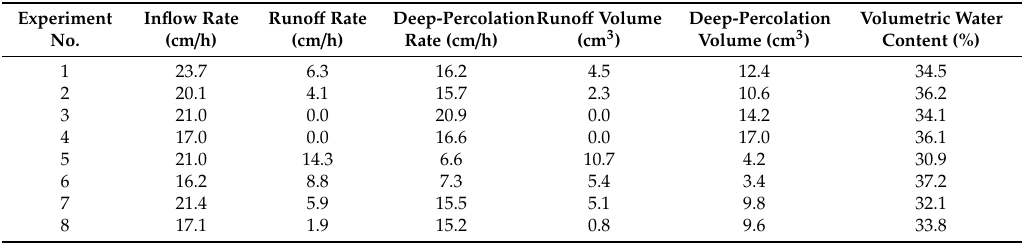
Table 3. Summary of steady state runo ff measured at the outlet and deep-percolation rates and volume measured at the drainage face as a ff ected by sand ditch treatment, soil type and bulk density. Experiment